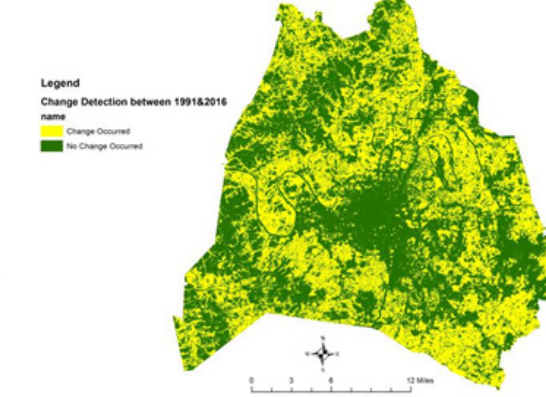
Fig. 8: Change detection areas between 1991 and 2016